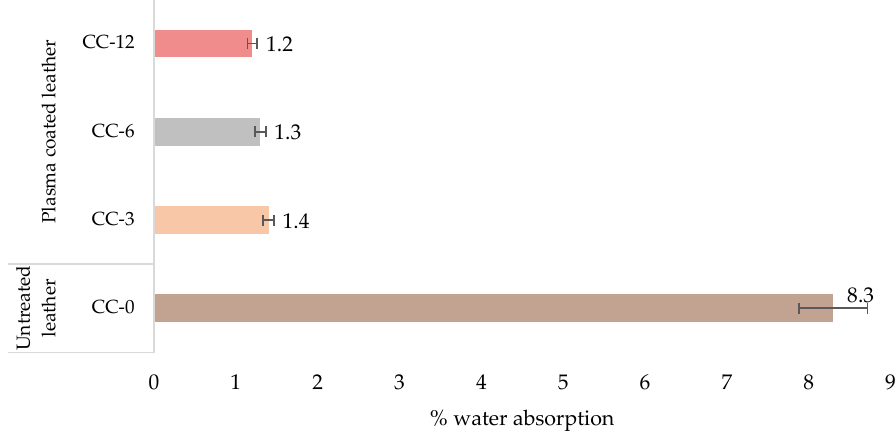
Figure 7. Water absorption (%) of plasma-coated and uncoated leather samples.